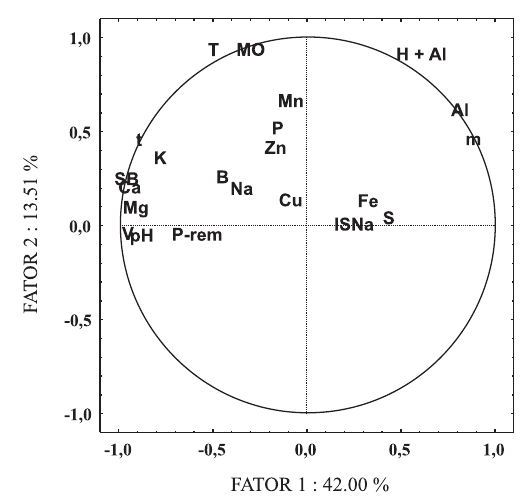
Figura 2. Círculo das correlações do plano formado pelos componentes principais 1 e 2.